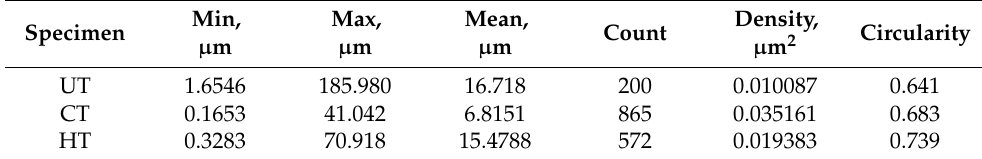
Table 6. Dimple sizes for UT, CT, and HT specimen.